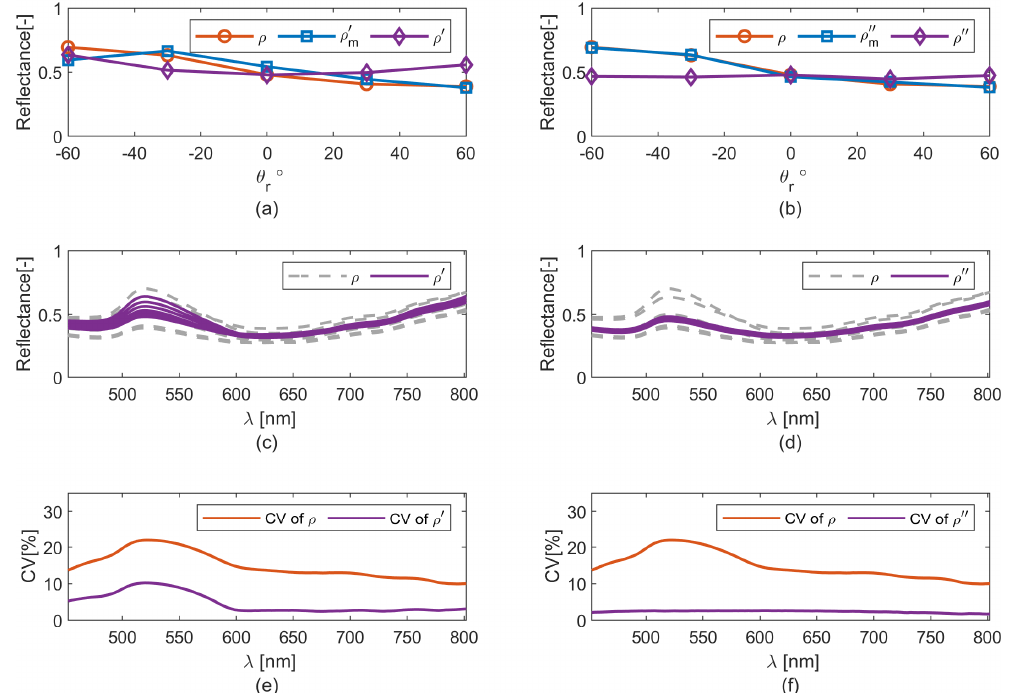
Figure 3. Evaluation of the BRDF correction models for the microstructure pattern B. Left and right columns, correction without considering and considering the spectral mixture, respectively. The second row presents the measured pixels' reflectance signatures before the BRDF correction (gray dashed lines) and after the correction (solid magenta lines). The third row shows the CV for each band before and after the correction.